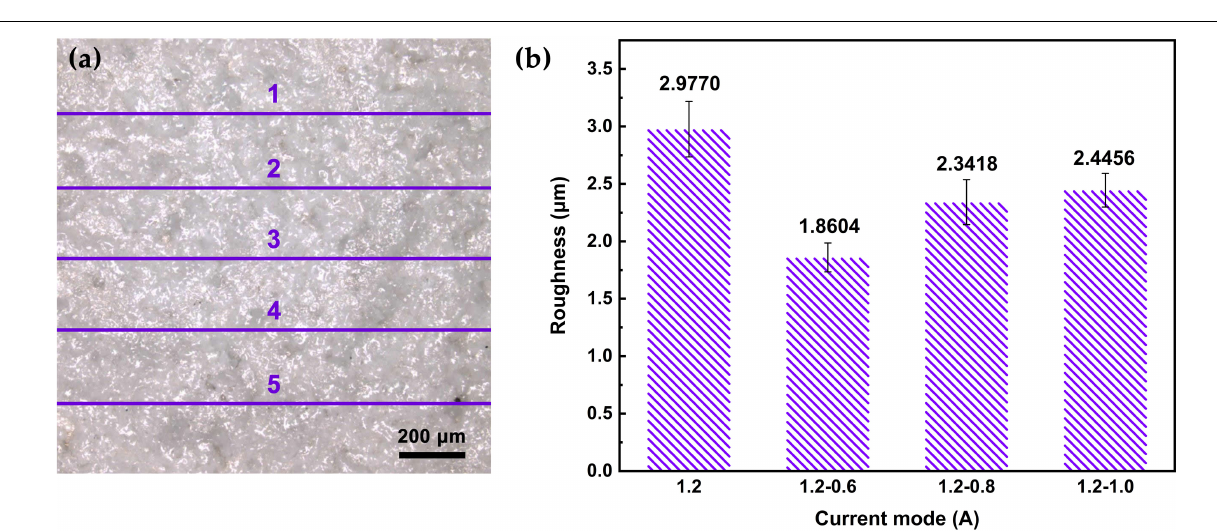
Figure 5b . The average Ra value of MAO coating under 1.2– 0.6 A mode is 1.8604 µ m, which is lower than that under the other three modes. Under the constant current mode, the surface